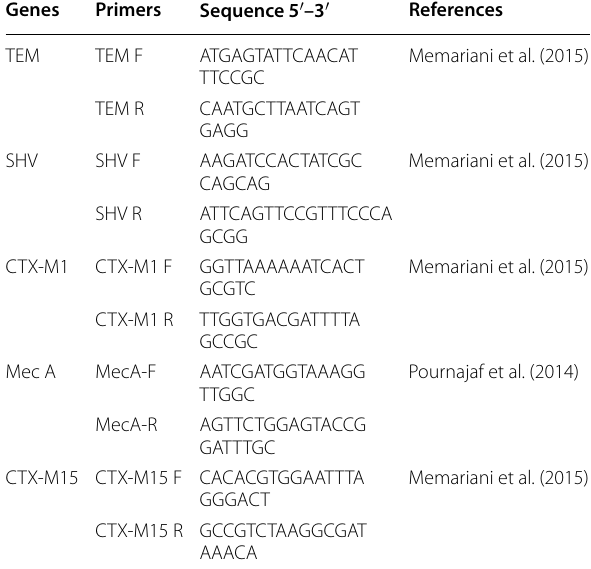
Table 1 List of genes and their primers